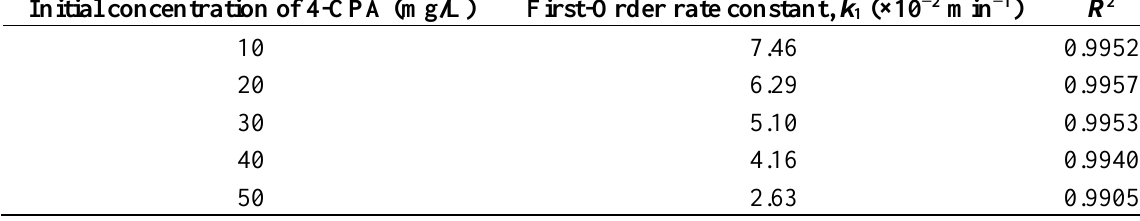
Table 7. First-order reaction rate, k Initial concentration of 4-CPA (mg/L)